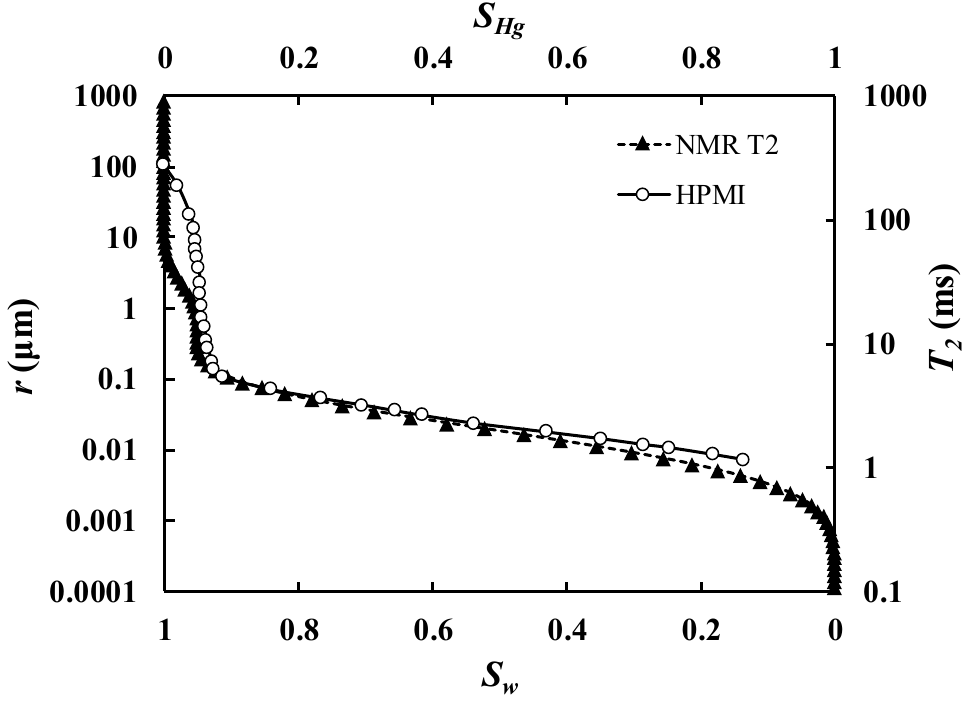
Figure 9. The cumulative mercury saturation with di ff erent pore throat sizes and cumulative water saturation with di ff erent NMR T 2 for Z39.